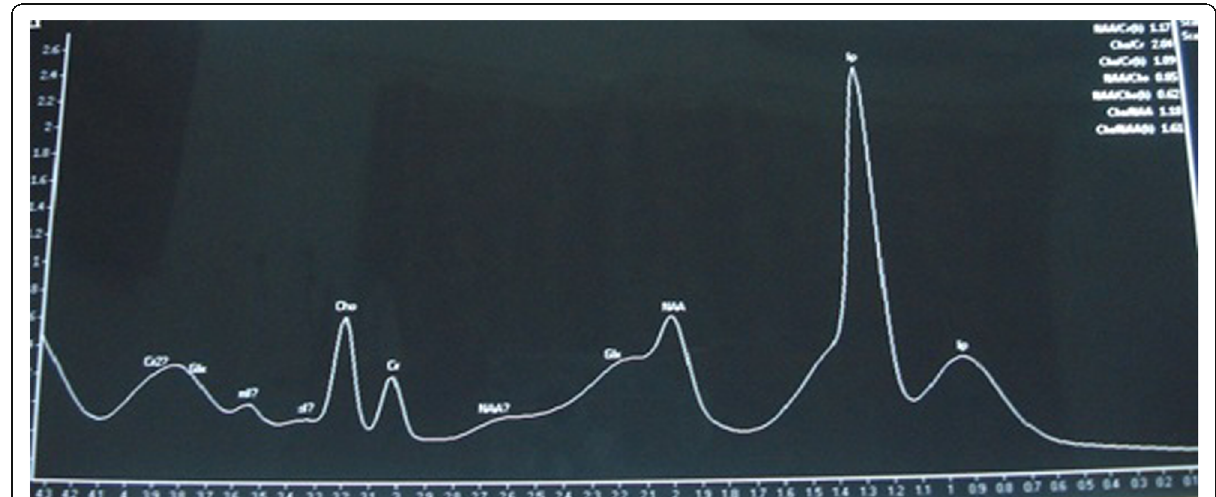
Fig. 6 Single-voxel spectroscopy obtained from the centre of the lesion showing markedly elevated lipid peak with depleted NAA, choline and creatine peaks